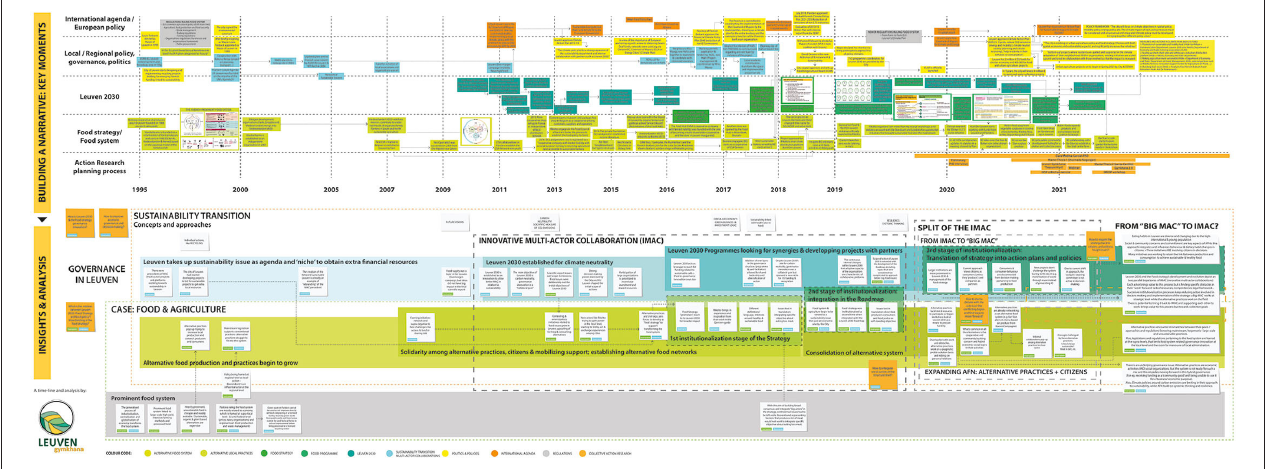
FIGURE 8 | Timeline gathering results and insights from the research about governance innovation and the implementation of the food strategy in Leuven used during the LeuvenGymkhana tours (Full resolution version included as Supplementary Material